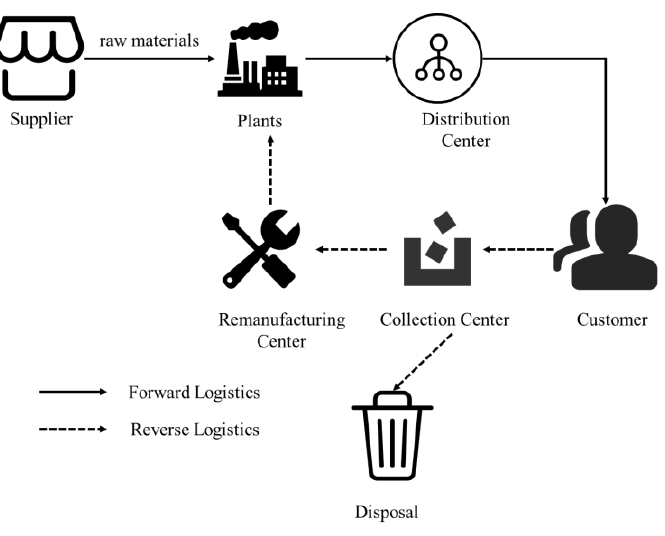
Figure 2. Closed-loop network structure.